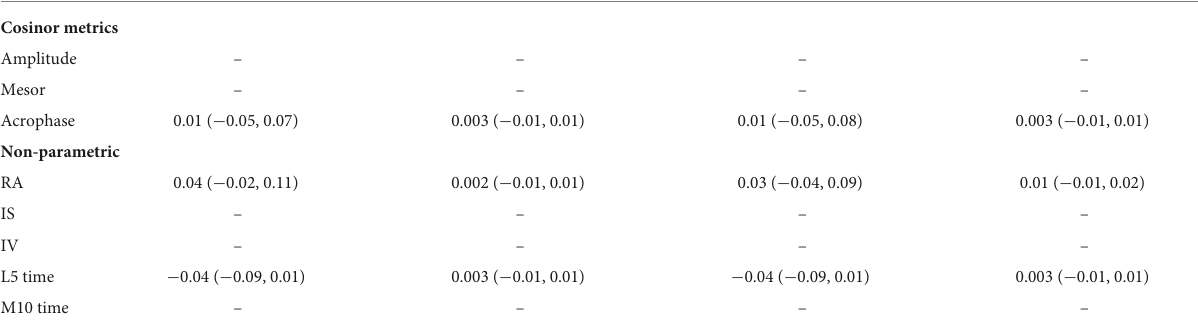
TABLE 7 Associations of circadian metrics with language, estimated beta (95%